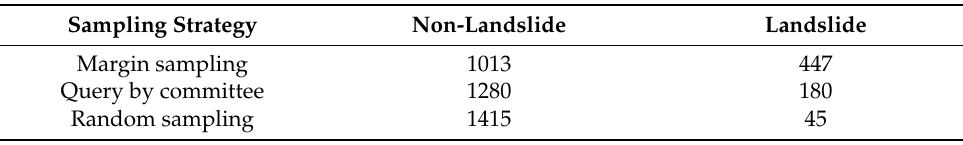
Table 2. Number of landslide and non-landslide instances in the training set after 50 epochs using different sampling strategies.